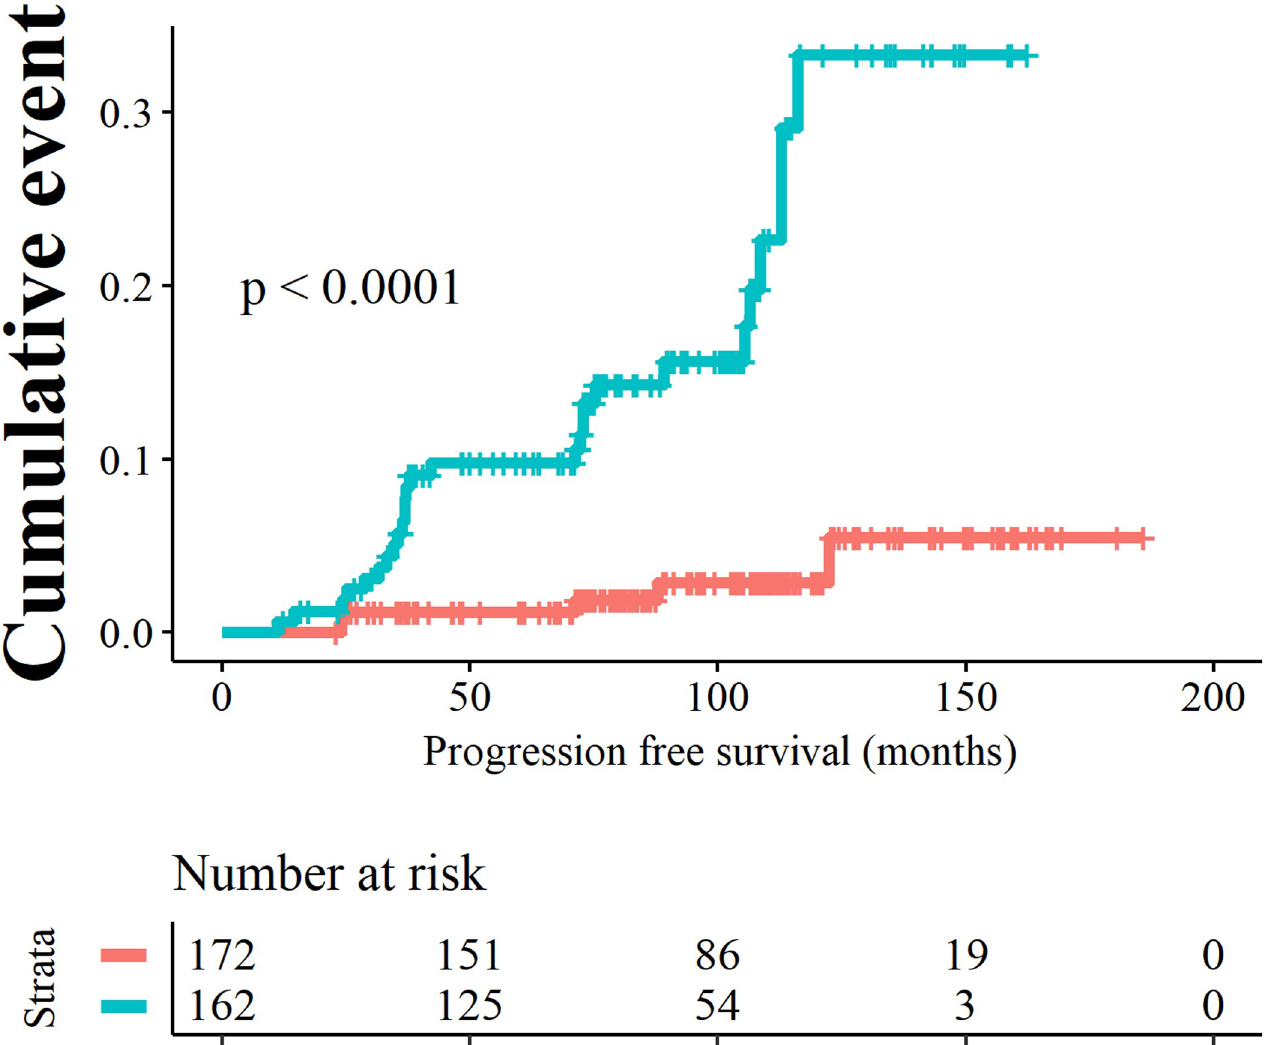
Fig 6. Kaplan Meier curves showing progression to HGD/EAC resulting from binary cut offs of the risk score at 8.1. Patients with a low risk score are depicted by the orange curves, patients with high risk scores are depicted by the blue curves.